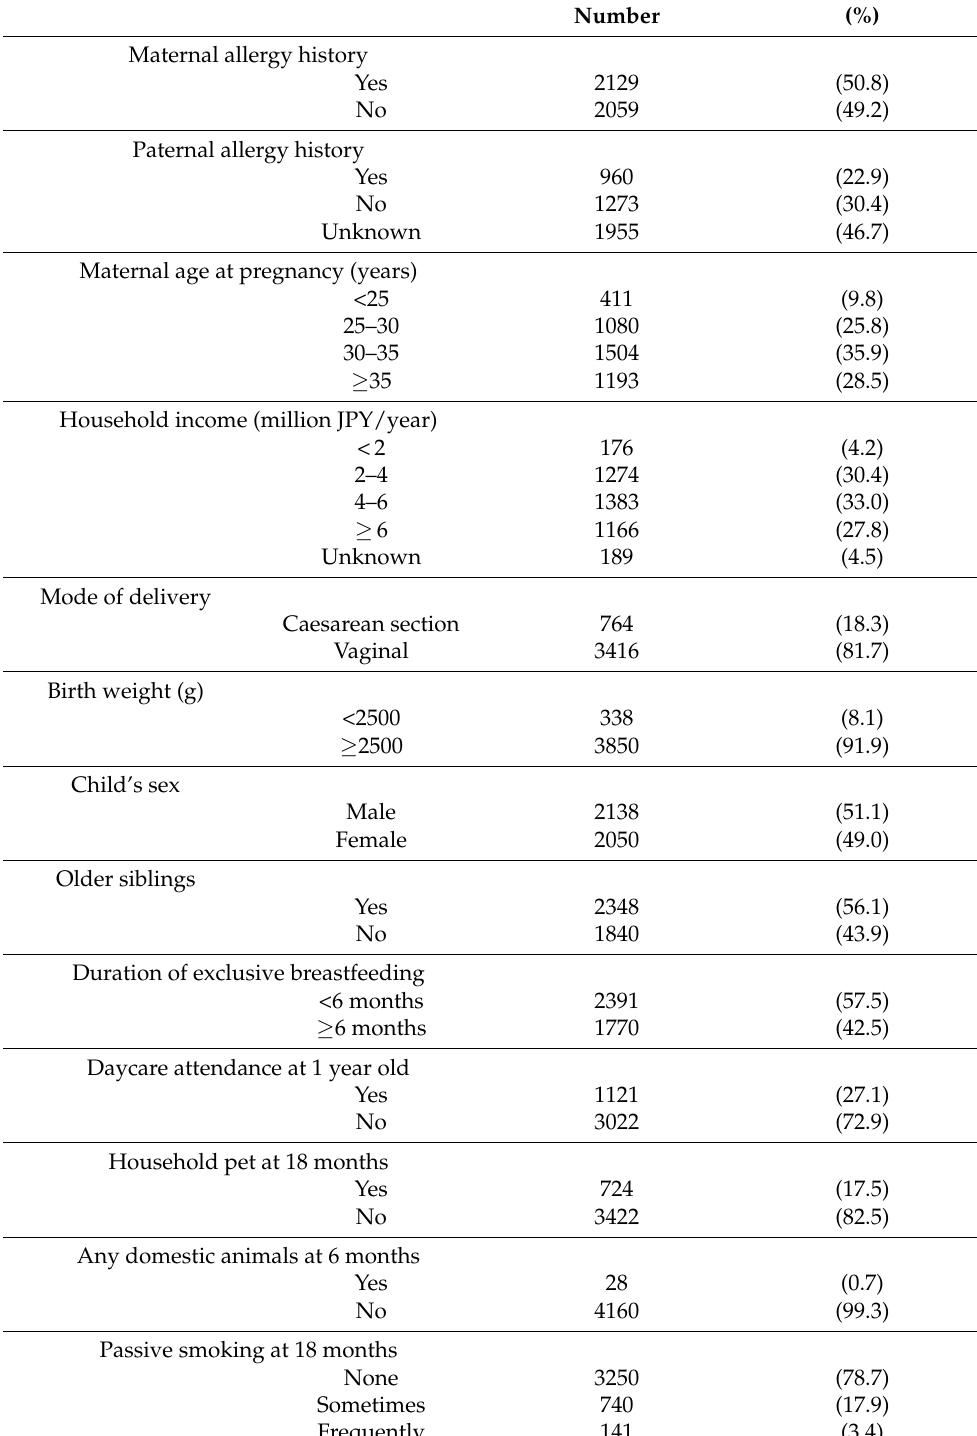
Table 1. Characteristics of the study participants ( n =